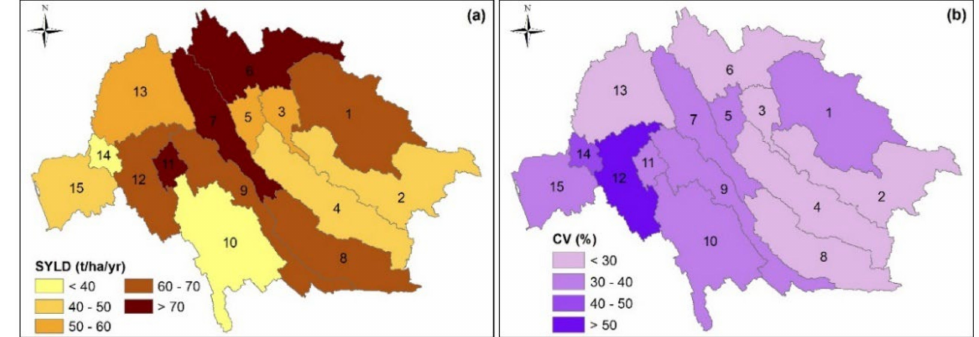
Figure 3. The model simulated ( a ) average annual sediment yield, and ( b ) coefficient of variation in sediment yield at sub-basin level for the baseline period (1991–2000) in Kalu River